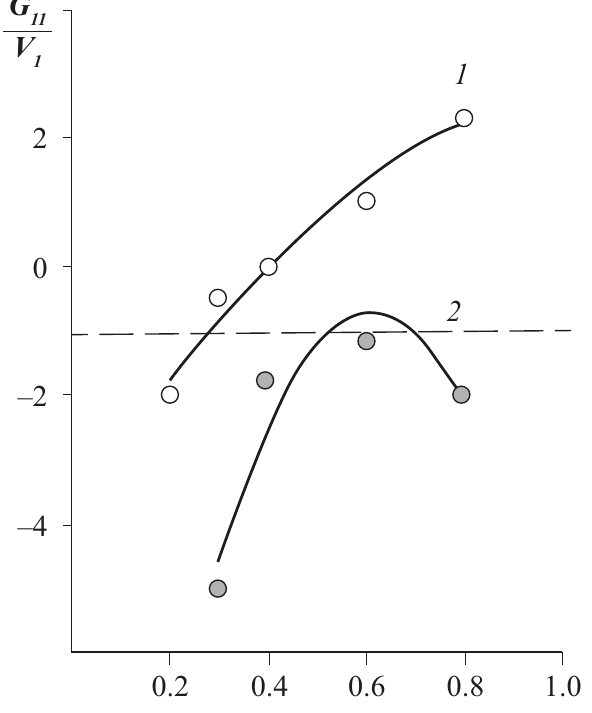
Figure 5. Integral of clustering of water molecules in the CA matrix with different degrees of substitution: 1—1.21; 2—2.6. The dotted line corresponds to G 11 / v 1 = − 1.